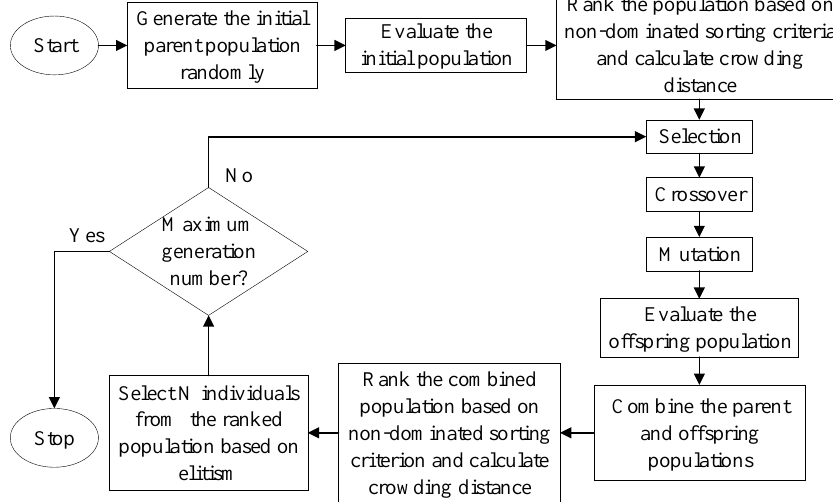
Figure 6. Flowchart of non-dominated sorting genetic algorithm II (NSGA-II).